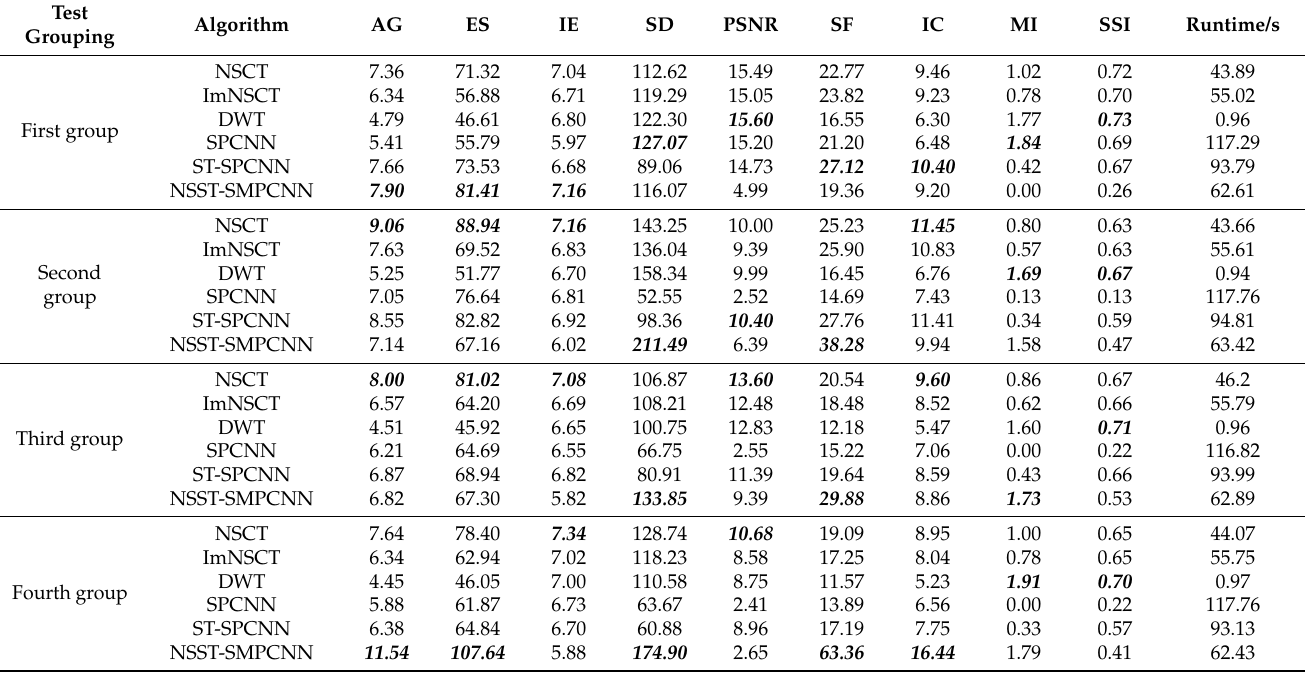
Table 3. Objective evaluation index results of dataset